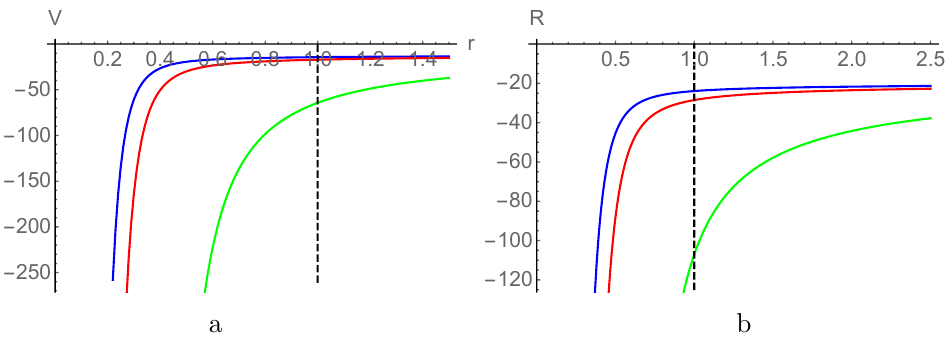
Figure 3 . Panel (a) shows the variation of dilaton potential V ( r ) for d = 4 and n = 1 and (b) shows the variation of Ricci scalar R . In both cases r h = 1 is considered. The blue curves indicate a = 0 : 05, the red curves a = 0 : 1 and the green curves a = 0 : 5. The dotted line represents r = r h